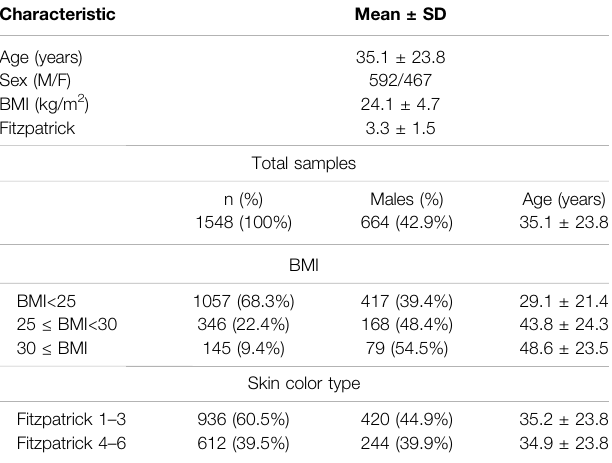
TABLE 1 | Demographic data of the participants.